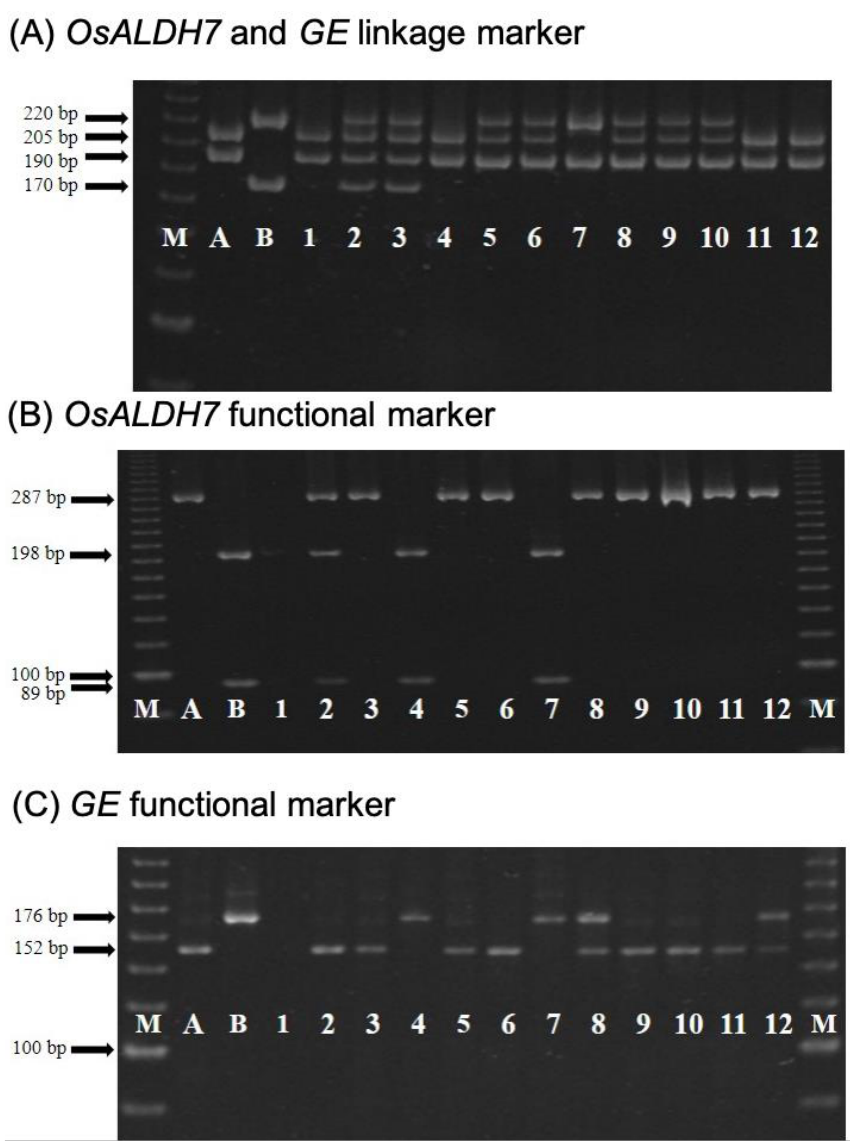
Figure 2. The breeding scheme for the purple functional rice population (PFR). Molecular markers were used for both foreground and background selections. Yield trials and antioxidant activity evaluations were performed. The numbers of the selected lines are enclosed in parentheses.